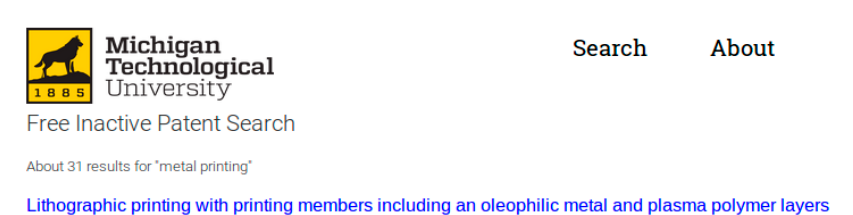
Inventions 2016 , 4 , 24